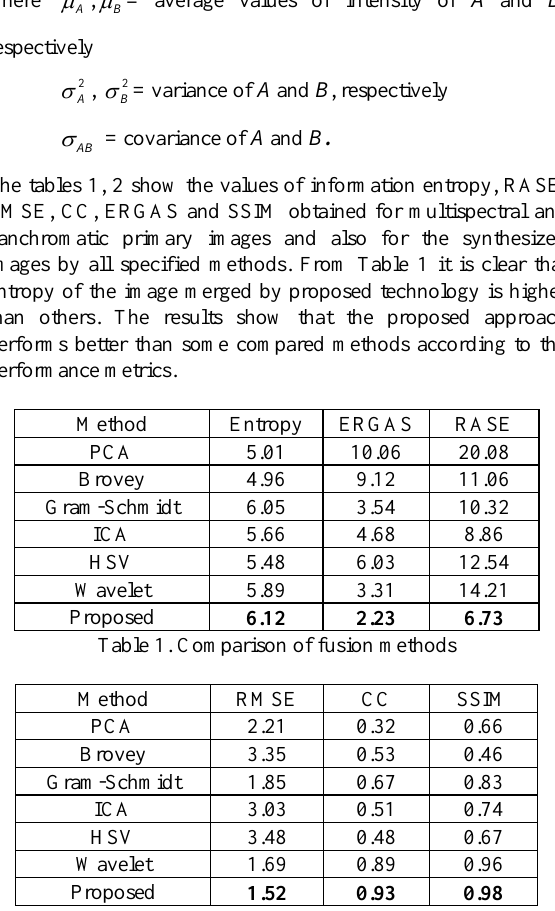
Table 2. Comparison of fusion